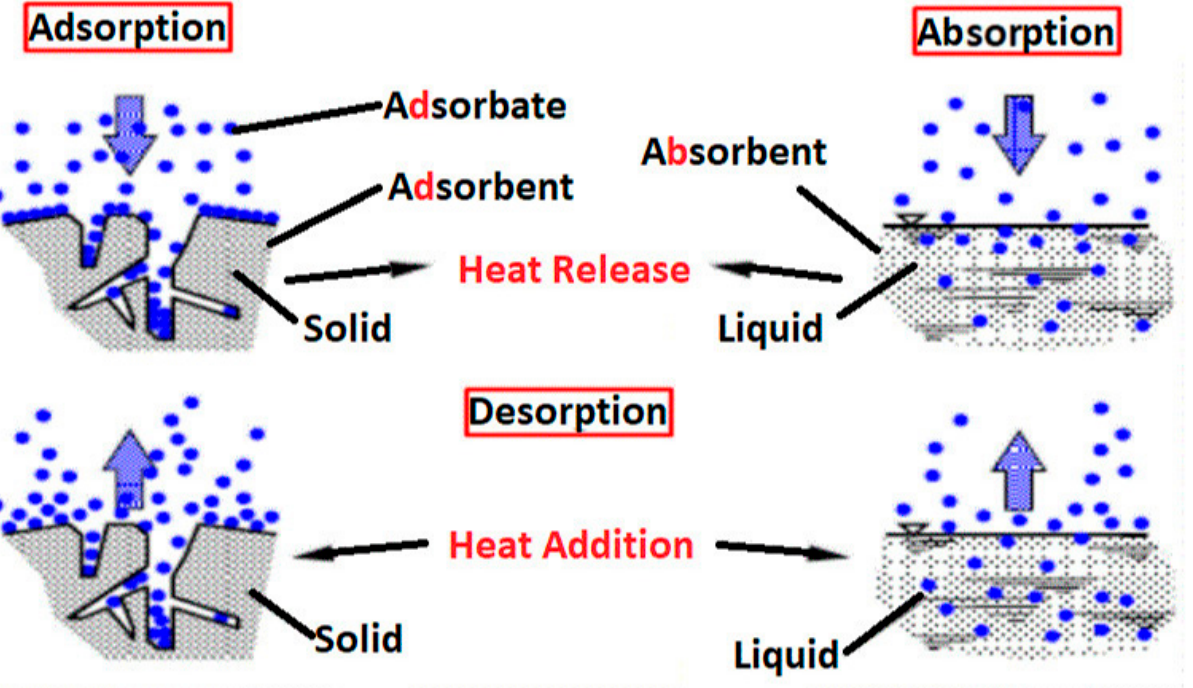
Figure 5. A comparison between absorption and adsorption